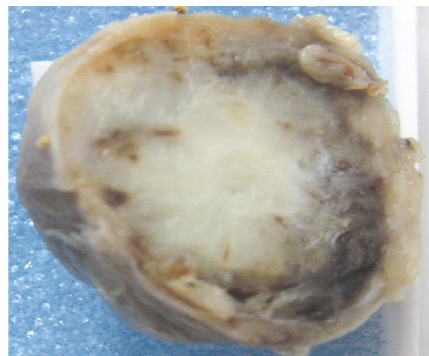
Figure 1: Grossly, the tumor had a pearly-white appearance and was well circumscribed, focally calcified with hemorrhagic alterations.